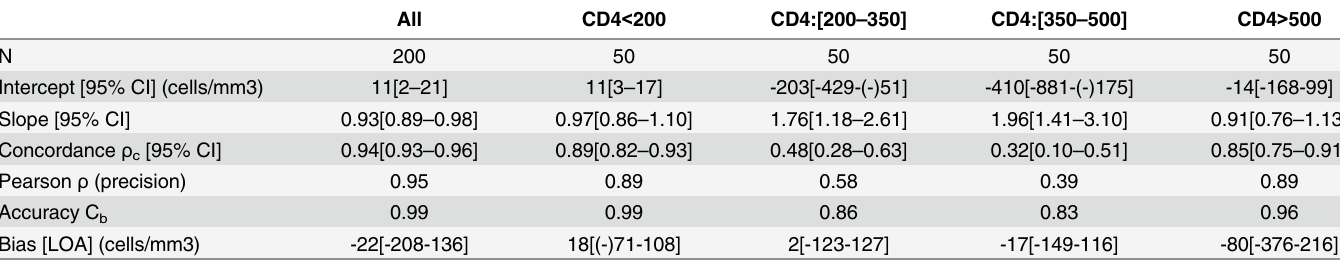
Table 2. Comparison of CD4 T-cell counts between Pima CD4 and FACSCount.